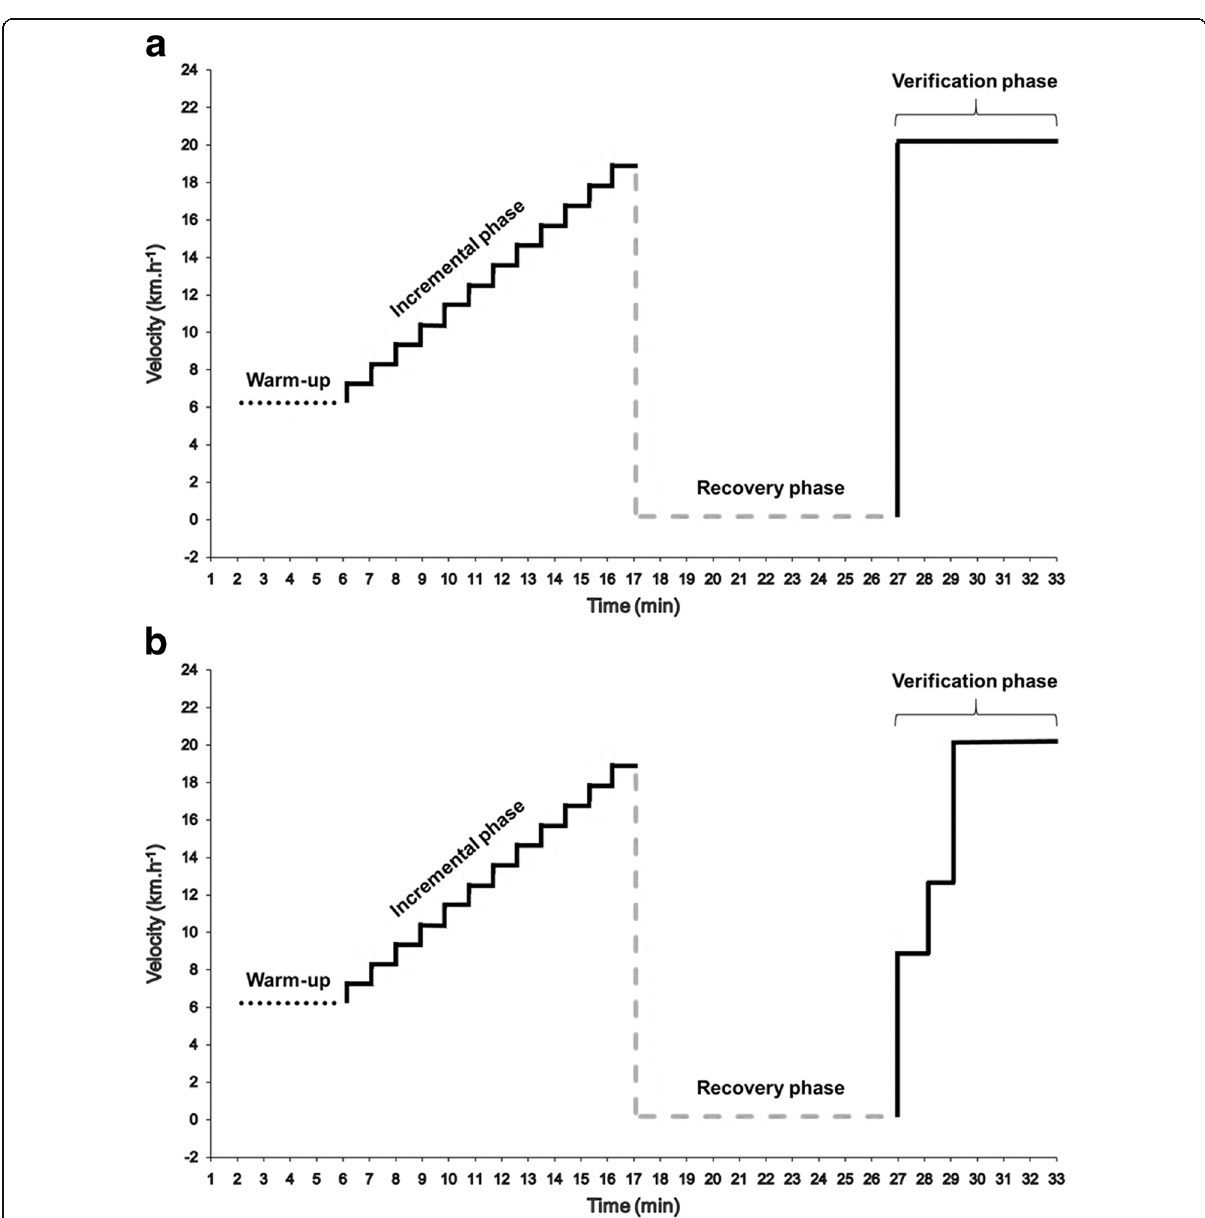
Fig. 1 Schematic illustration of an incremental test followed by either a square-wave ( a ) or a multistage ( b ) verification phase. Incremental protocol consists of a 5-min warm-up followed by 1 km h − 1 increments every minute until exhaustion (i.e. 19 km h − 1 ). After 10 min of passive recovery, an effort at one stage higher (20 km h − 1 ) than the last stage completed during the incremental phase is performed directly ( a ) or preceded by a “ warm-up ” corresponding to 2 min at 50% and 1 min at 70% of the maximal velocity reached during the incremental phase ( b